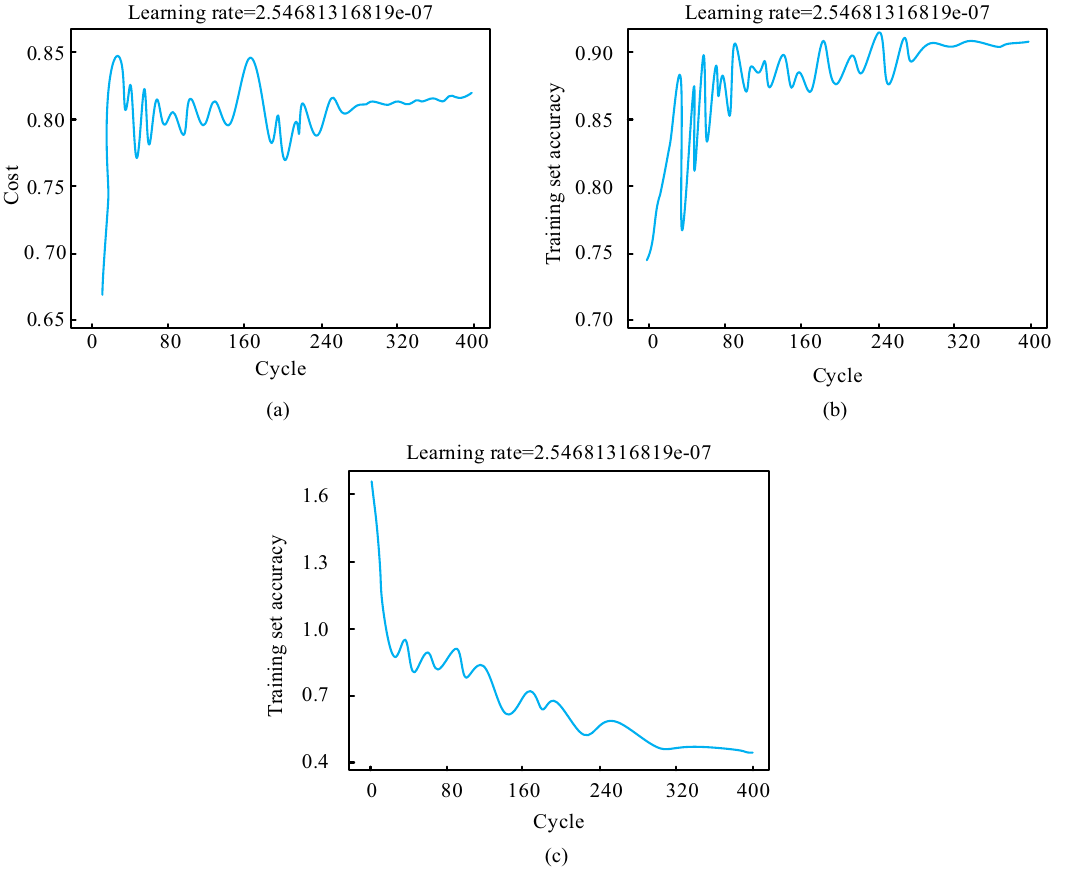
Figure 8: Cost and accuracy of encrypted datasets ( 400 cycles ) : ( a ) cost, ( b ) training set accuracy, and ( c ) validation set